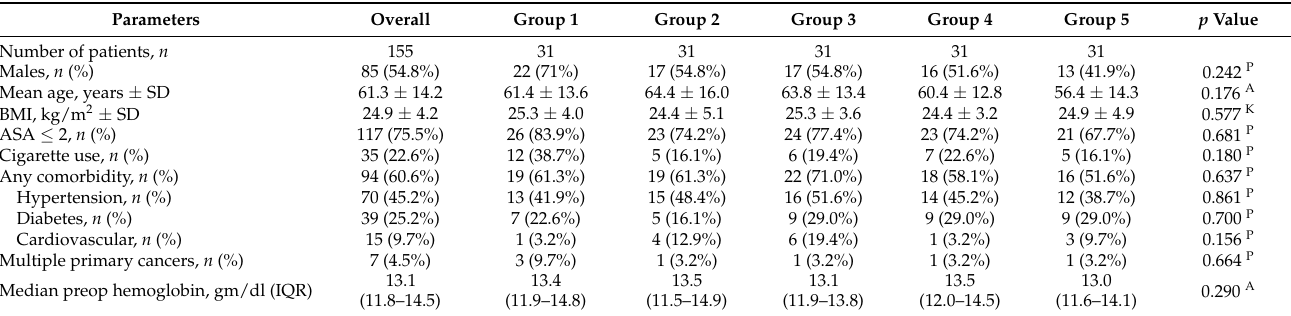
Table 2. Demographic analysis of patient